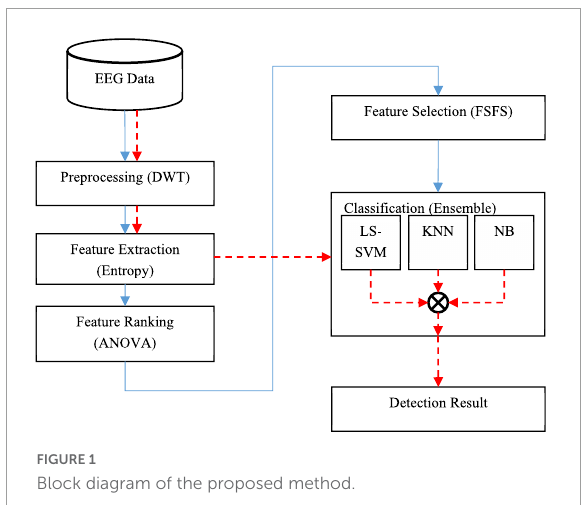
FIGURE1 Block diagram of the proposed method.